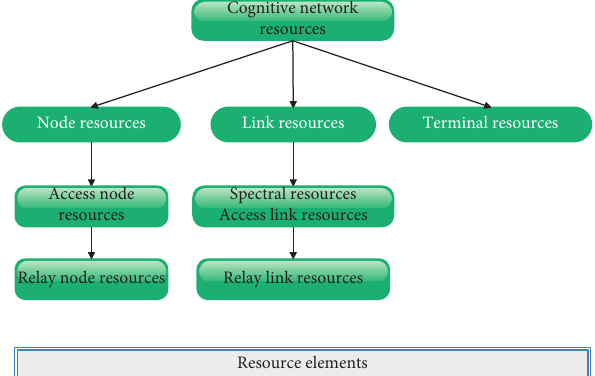
Figure 2: The first-level functional decomposition structure of network engineering cost data.